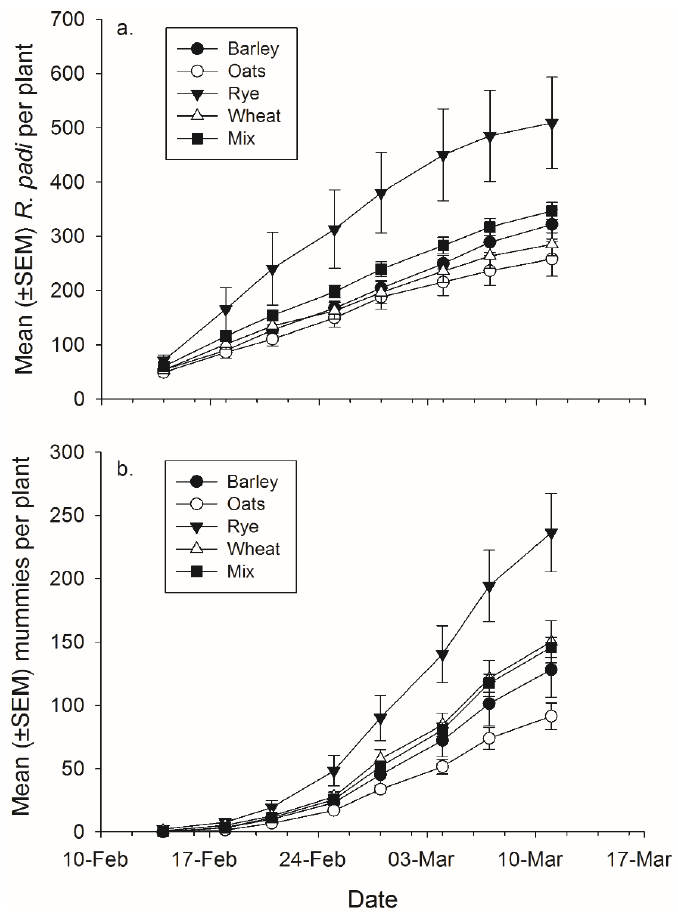
Figure 5. Mean (±SEM) total number of ( a ) R. padi produced and ( b ) mummies produced on mixtures and each plant species in